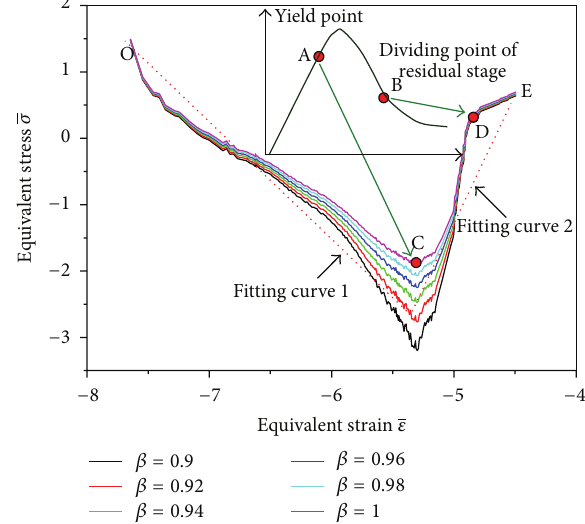
Figure 12: Relation between equivalent stress and equivalent strain when confining pressure was set to